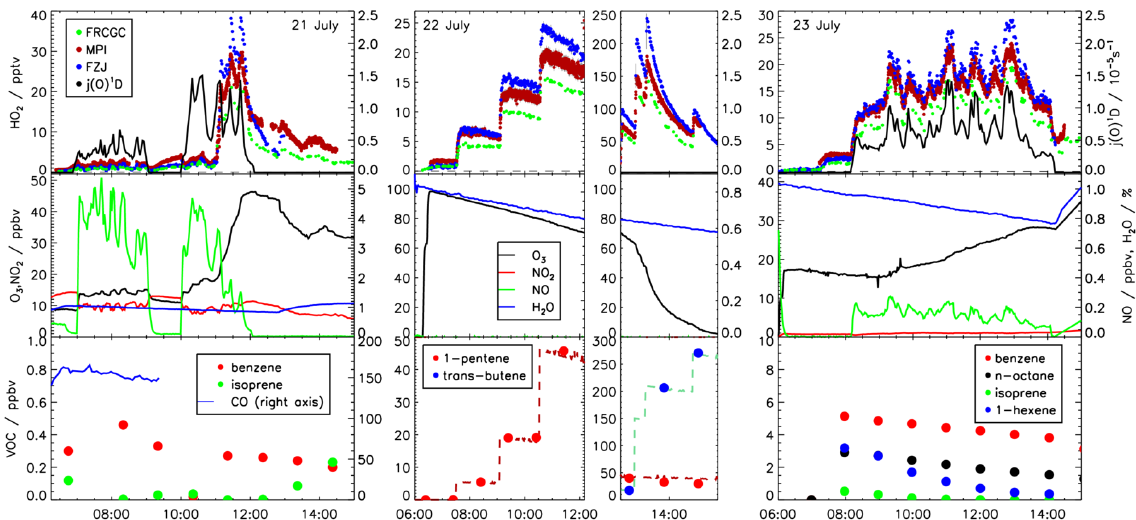
Fig. 4. Same as Fig. 2 for the last three SAPHIR experiments. In addition, mixing ratios of organic compounds are shown. The scaling of axis showing HO 2 mixing ratios changes during the experiment on 22 July, because HO 2 mixing ratios were rapidly increased to values, which are ten times higher than encountered during the rest of the campaign. On 21 July the CO mixing ratio was increased to 500ppmv at 11:00 (not shown here). On 22 July dashed lines in the lower panel show calculated mixing ratios of 1-pentene and trans-butene. The time series is calculated from the times of the addition of alkenes and their dilution and absolute levels are scaled to measurements by GC-FID